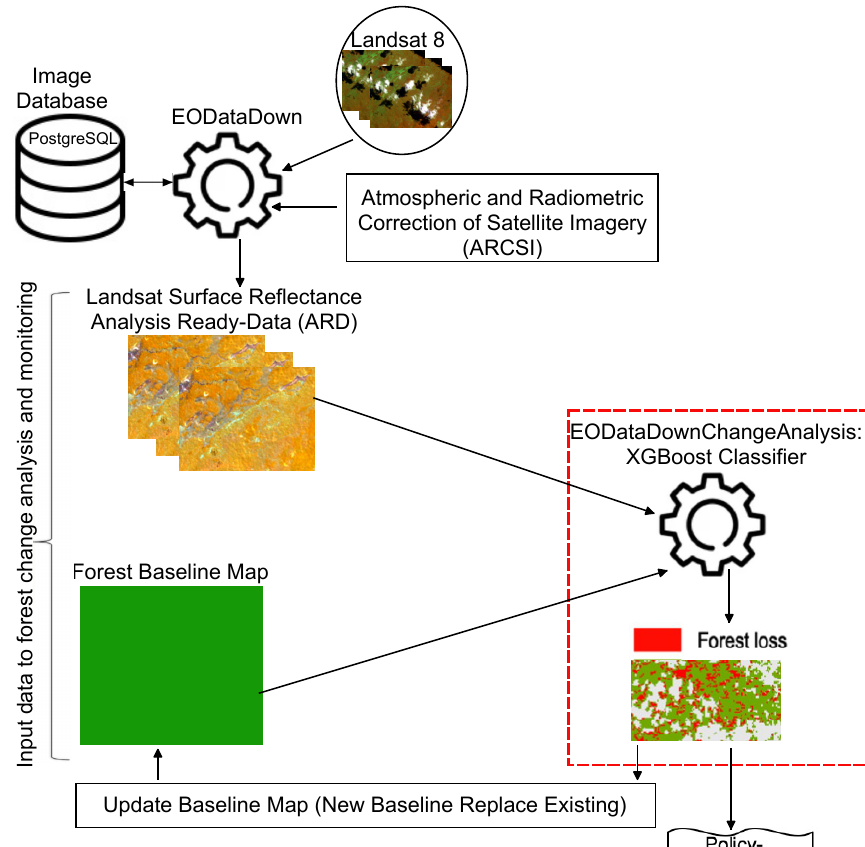
Figure 3. Forest change and monitoring system